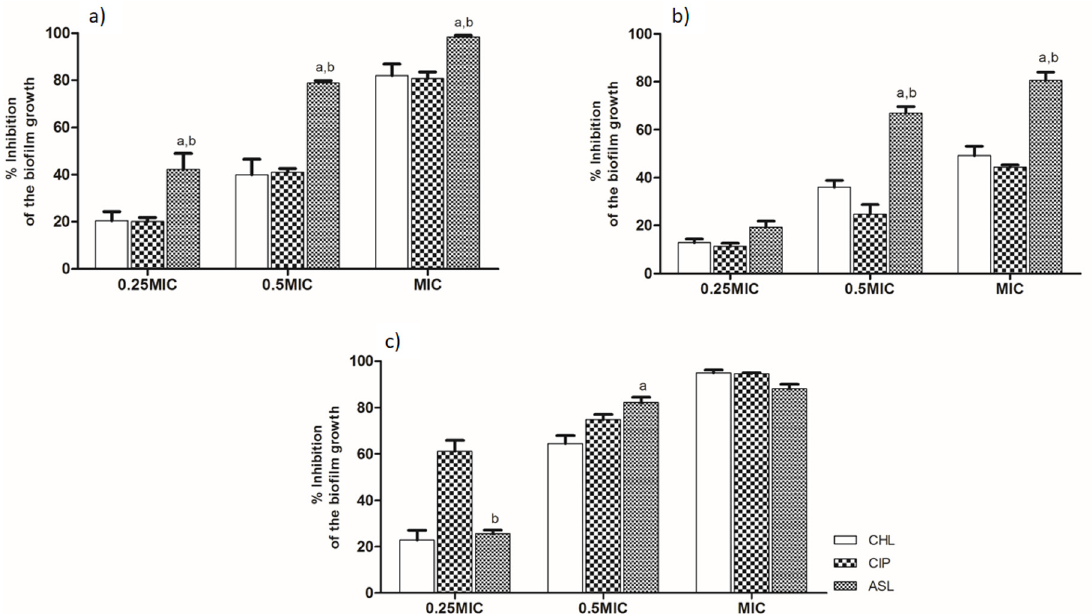
Figure 3 - The effect of methanolic extract of Annona squamosa leaves (ASL) on the established biofilms of a ) S. aureus ; b ) K. pneumoniae and c ) E. faecalis . Choramphenicol (CHL) and ciprofloxacin (CIP) were used as positive controls. Each data point represents mean ± SD from at least two independent experiments performed in triplicate. a Statistically different from chloramphenicol. b Statistically different from ciprofloxacin (ANOVA followed by Bonferroni, P < 0.05).